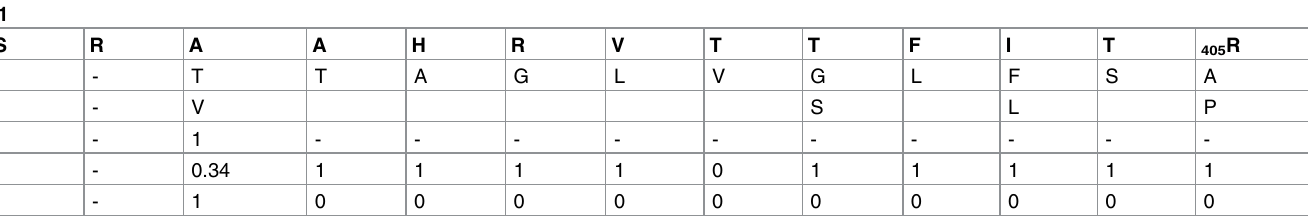
Table 6. Tolerance to the amino acid substitution in the epitopes targeted by